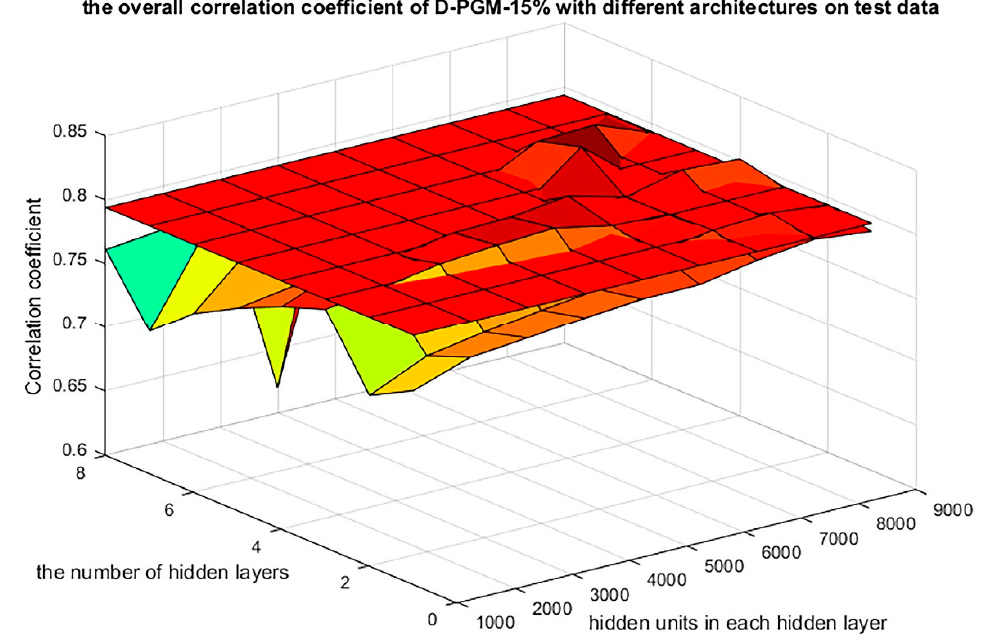
Figure 7. The overall PCC performance of D-GPM-15% with various architectures for the MBV-te. The overall PCC performance of SVM for the MBV-te is shown as a cross section, which is 0.794183 high in terms of the PCC and serves as a benchmark to evaluate the PCC of D-GPM-15% with various architectures.